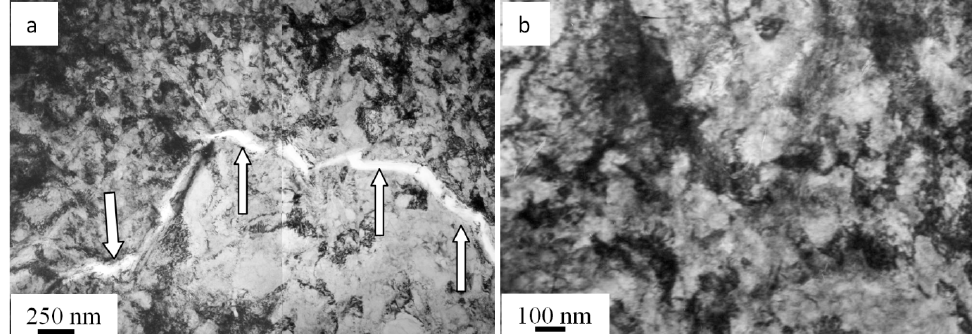
Figure 5. Microcracks forming along boundaries of grains containing second-phase impurities ( а ) fragmented substructure ( b ) in fractured AISI 310S steel when fatigued.